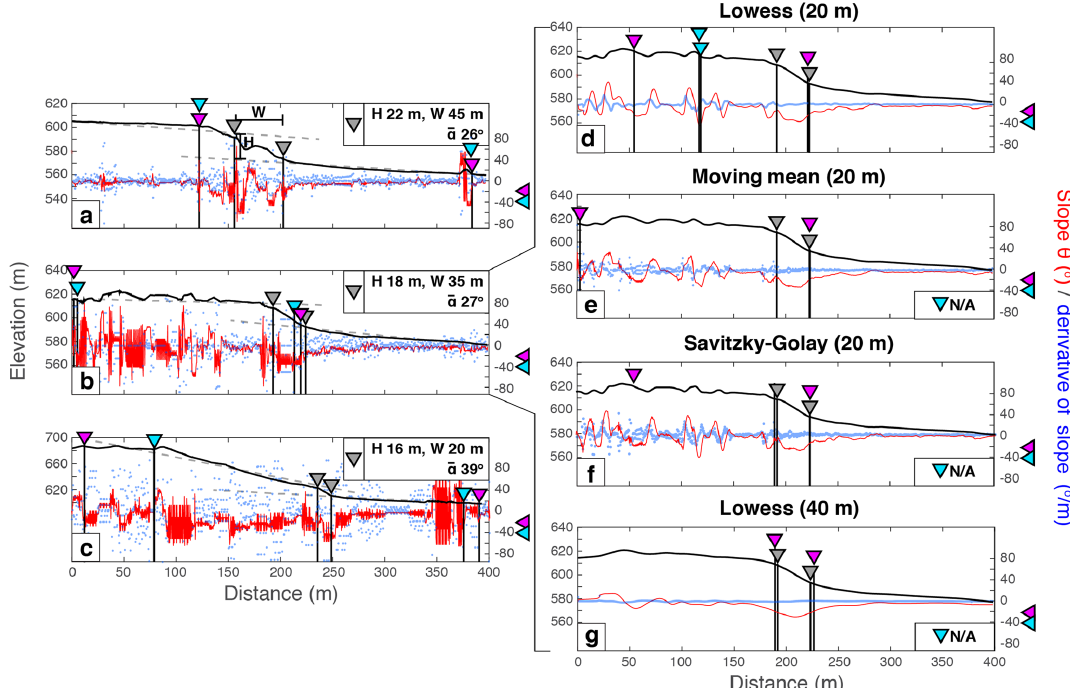
Figure 2. Panels (a) to (c) show three profiles across the Bilila–Mtakataka fault scarp using the Pleiades 5m DEM. Each is characteristic of the different challenges associated with picking the fault scarp manually and using an algorithm. Profile A has a clearly defined scarp, although the scarp itself contains non-tectonic topographic features making it difficult to quantify its shape. Profiles B and C have more distributed topographic noise, and Profile C has a scarp that is difficult to accurately identify as the magnitude of the change in slope at the fault scarp is not large. Using Profile B, four different digital filters and/or bin widths were applied: (d) Lowess (bin width 20m); (e) moving mean (bin width 20m); (f) Savitzky–Golay (bin width 20m); and (g) Lowess (bin width 40m). The black line is the elevation profile, the red line is the slope ( θ ) profile, and blue circles denote the derivative of slope ( φ ). Grey triangles show the location of the crest and base of the fault scarp based on a manual pick. Pink and blue triangles denote the algorithm’s pick of the crest and base based on a slope threshold of 20 ◦ (pink) and 40 ◦ (blue),